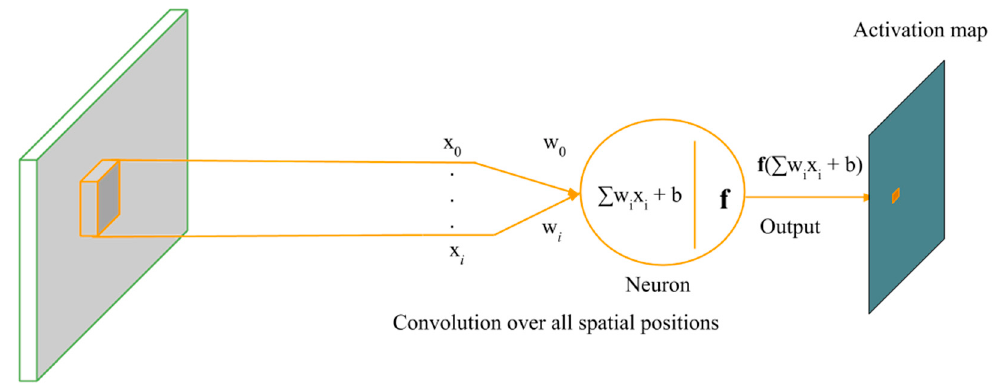
Figure 3. Illustration of the operation performed by a single neuron of the convolutional